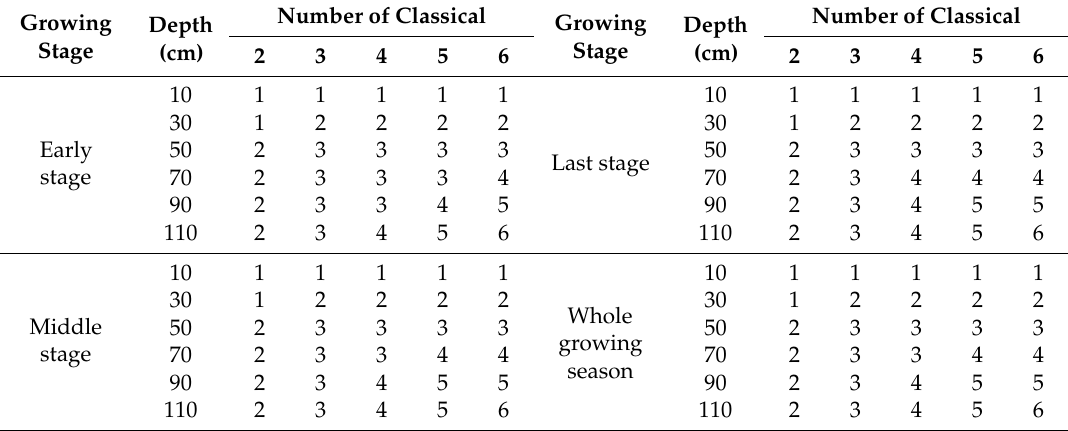
Table 3. Description of soil moisture variables at different depths in the soil profile. Number of classical refers to the categories divided for soil moisture variables in the soil profile; 2 refers to the two categories of soil moisture variables.